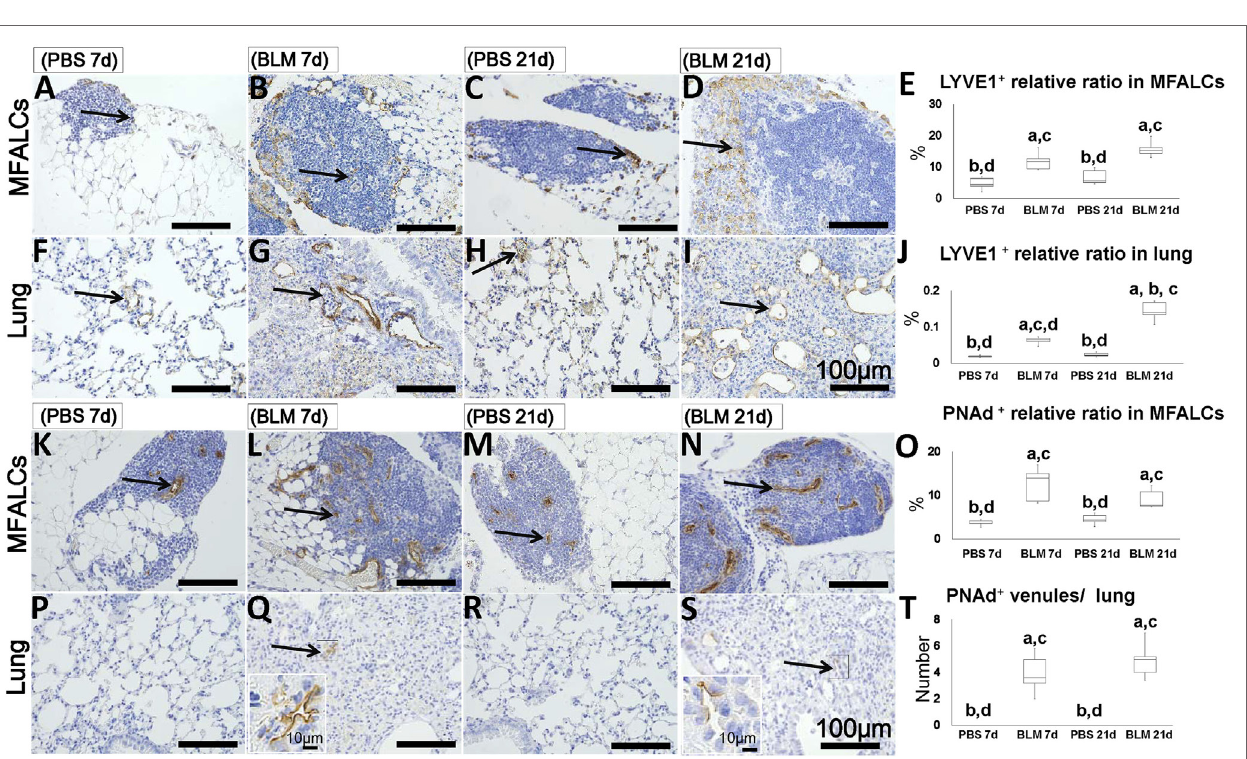
FigUre 6 | Presence of LVs and high endothelial venules (HEVs) in mediastinal fat-associated lymphoid clusters (LCs) (MFALCs) and lungs of Bleomycin (BLM)-induced pneumonitis in mice. Immunohistochemical images depict LYVE1 + LVs in MFALCs (a–D) and lung tissues (F–i) in phosphate-buffered saline (PBS) group at 7 days, BLM group at 7 days, PBS group at 21 days, and BLM group at 21 days, respectively. Arrows indicate LYVE1 + LVs in MFALCs (a–D) and lung tissues (F–i) . Percentage of LYVE1 + LVs in MFALCs (e) and lung tissues (J) of different groups. Immunohistochemical images of PNAd + HEVs in the MFALCs (K–n) and lung tissue (P–s) are shown for PBS group at 7 days, BLM group at 7 days, PBS group at 21 days, and BLM group at 21 days, respectively. Arrows indicate PNAd + HEVs in MFALCs (K–n) and lung tissues (P–s) . (O) Relative ratios of PNAd + HEVs in the MFALCs. (T) Average number of PNAd + HEVs in lung tissues. The letters a, b, c, and d: significant differences between PBS group at 7 days (a), BLM group at 7 days (b), PBS group at 21 days (c), and BLM group at 21 days (d), analyzed by the Kruskal–Wallis test, followed by the Scheffé’s method ( P < 0.05); n = 5 in each experimental group. Values = mean ±